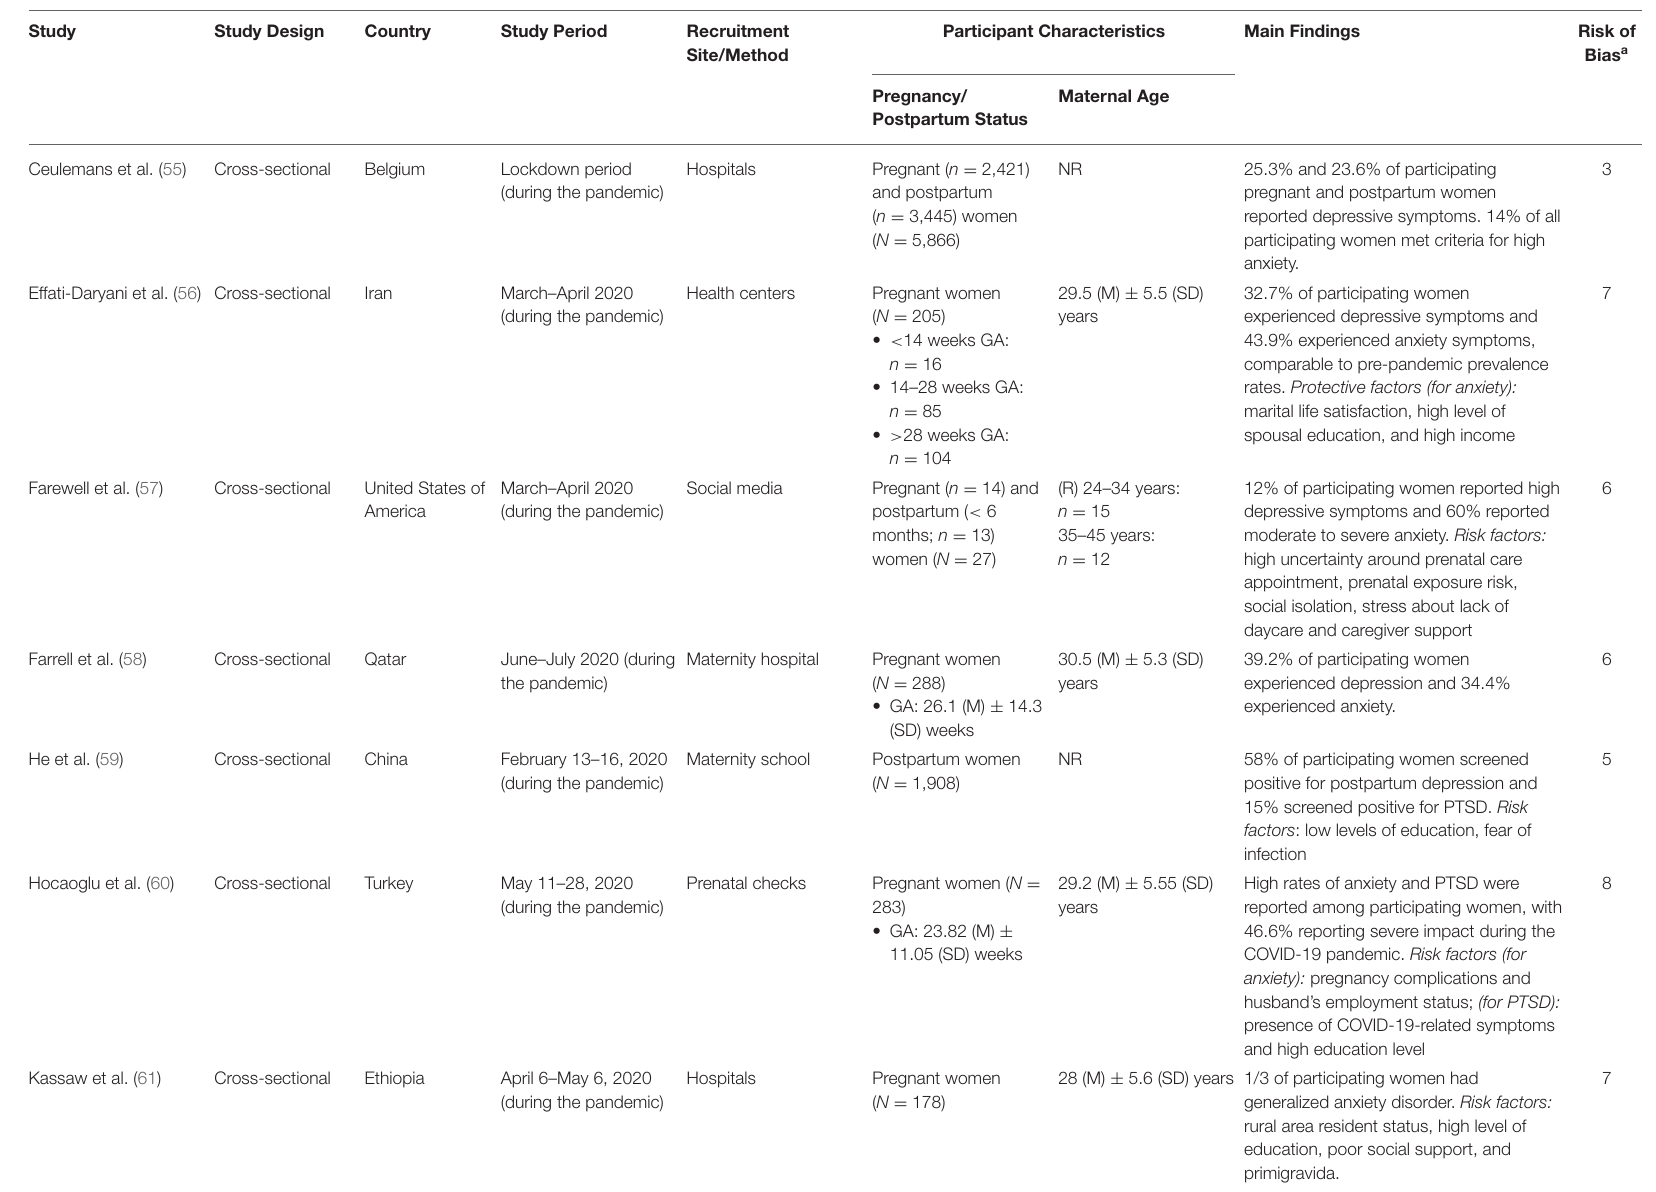
TABLE 1 | Prevalence of mental health outcomes in pregnant or postpartum women during the COVID-19